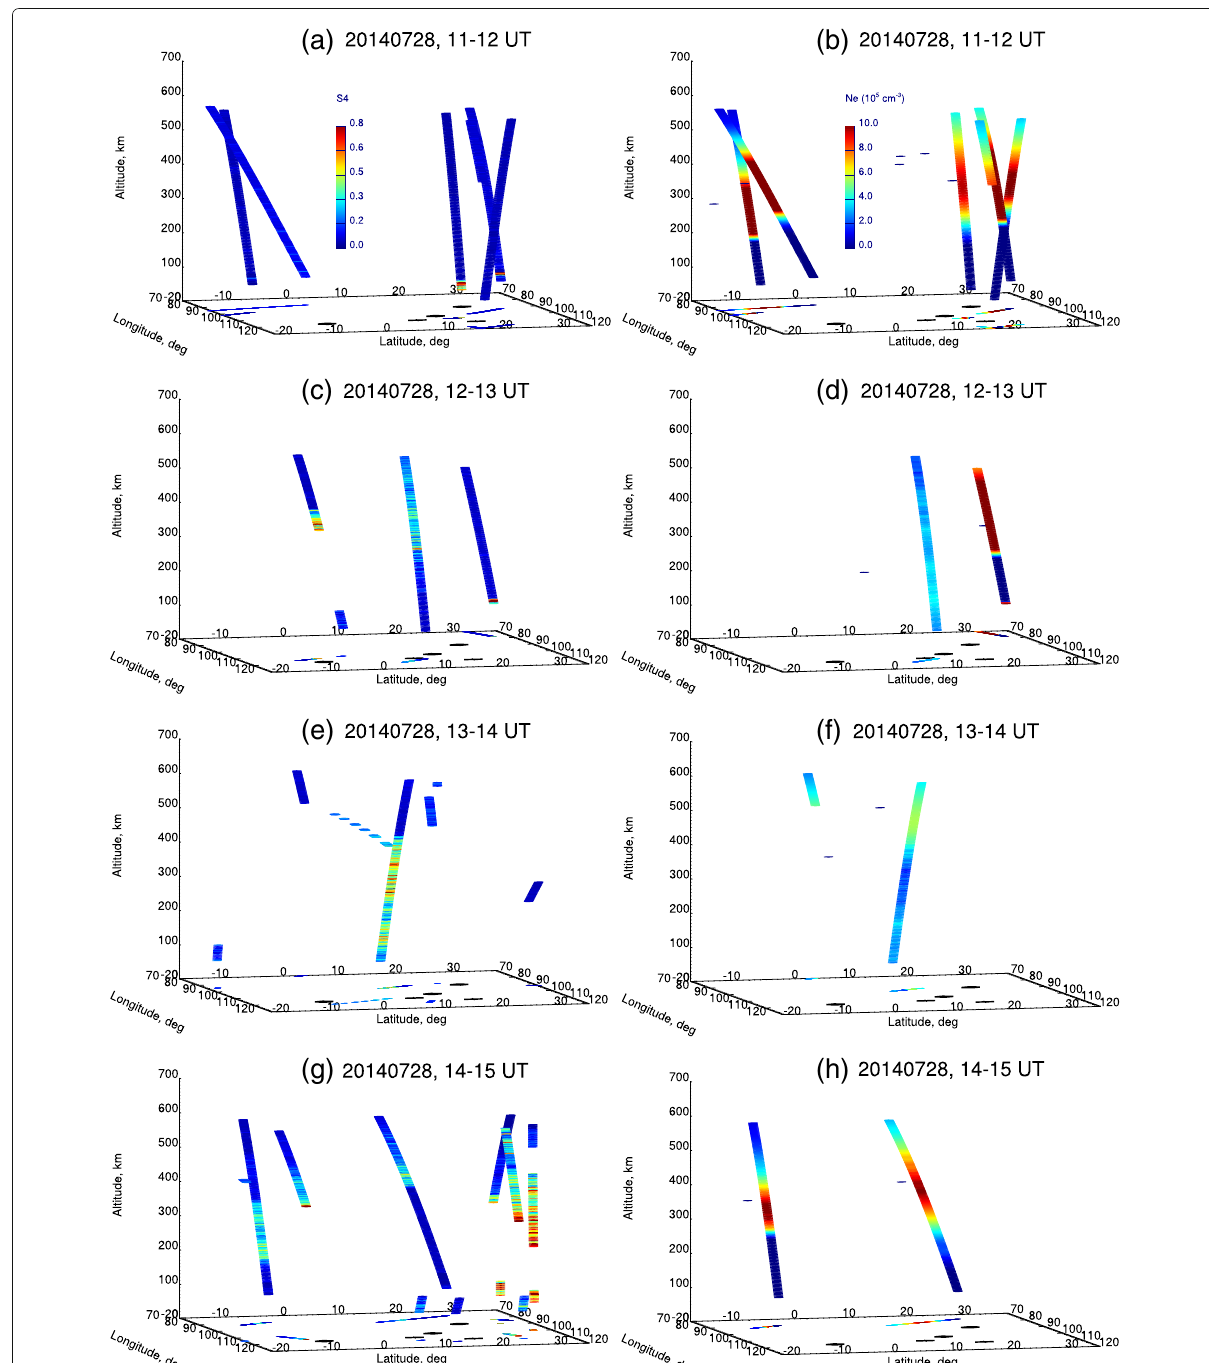
Fig. 4 Altitude - latitude - longitude plots restricted to the red rectangle in Fig. 2, showing the tangent point locations of the RO events that sampled the ionosphere each hour from 11 UT (top row) until 15 UT (bottom row) on 28 July 2014. The tangent points (and their respective projections in the latitude-longitude plane) in the left and right columns are colored according to the measured S4 index and electron density, respectively. The black dashes in the altitude-latitude plane in the right column show the peak electron density altitudes measured for each RO event. The black symbols in the latitude-longitude plane indicate the station locations, as in Fig. 2. Note that RO profiles are plotted from 80 to 600 km altitude in this figure a 20140728, 11-12 UT, b 20140728, 11-12 UT, c 20140728, 12-13 UT, d 20140728, 12-13 UT, e 20140728, 13-14 UT, f 20140728, 13-14 UT, g 20140728, 14-15 UT, h 20140728, 14-15